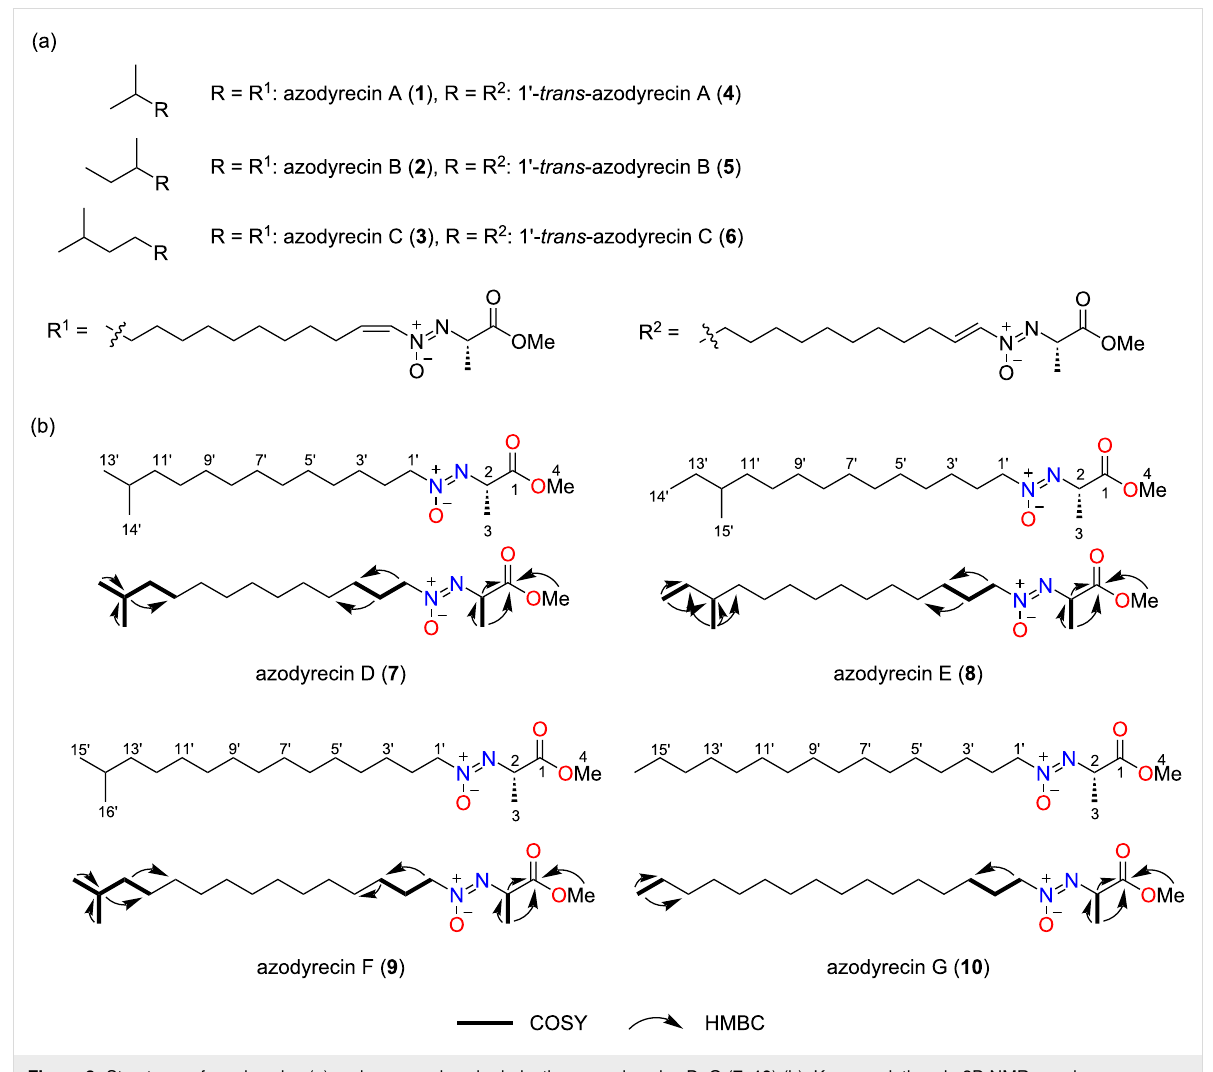
Figure 3: Structures of azodyrecins (a) and new azodyrecin derivatives, azodyrecins D–G ( 7 – 10 ) (b). Key correlations in 2D NMR are shown.